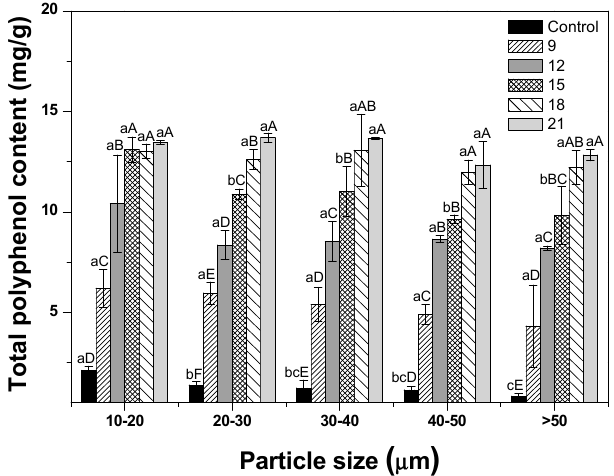
Figure 6. Total polyphenol content of dried ginseng powders with different particle sizes according to roasting time. After cryogenic milling of ginseng samples with different conditions, the samples were classified by their particle sizes. One treatment condition in each size range was then selected, and samples selected by particle size were then roasted and pulverized by cryogenic milling. a–c Means with different superscripts within the same time group are significantly different ( p < 0.05; Duncan’s test). A–E Means with different superscripts within the same size group are significantly different ( p < 0.05; Duncan’s test).